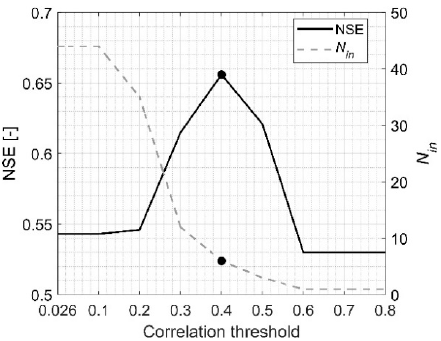
Figure 5. The effects of a correlation threshold for the PCAF and CCF values on the NSE of SLSTM over the validating period below (see the black line). The dashed line on the right axis denotes the number of inputs ((cid:1840) (cid:3036)(cid:3041) ) including principal predictors and their time lags for each threshold. The black dots indicate the optimal threshold value. The first 4680 days (80%) data and the next 580 days (10%) are employed for training and validation, respectively. The hyper-parameters suggested by Kratzert, Klotz [37] are employed.